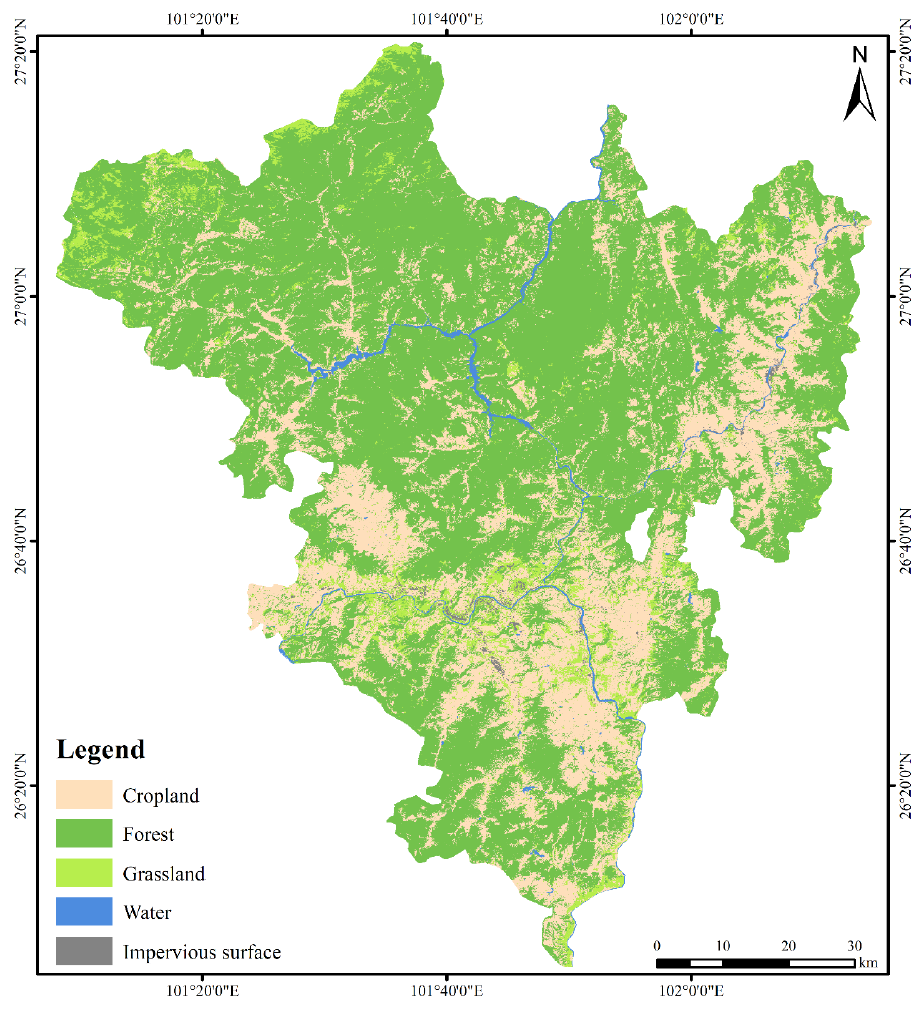
Figure A3. Spatial Distribution of RSEI and Hotspots and Coldspots in Zhulan Mine (( a ): Spatial Distribution of RSEI, ( b ): Spatial Distribution of Hotspots and Coldspots).